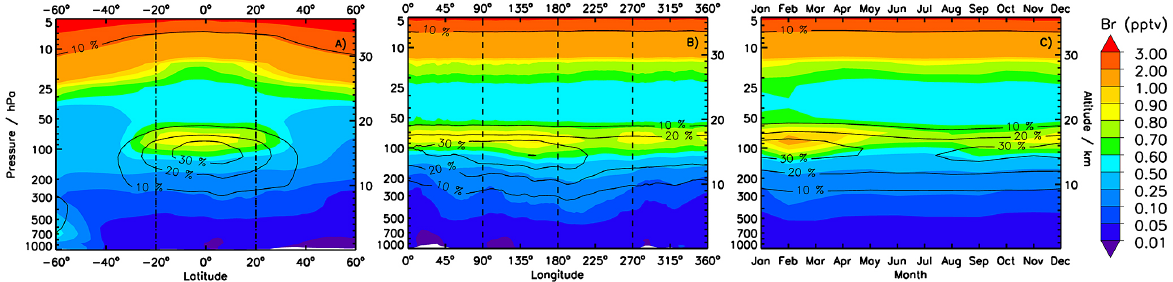
Figure 3. The “tropical ring of atomic bromine”: (a) annual zonal average; (b) annual meridional average abundance of atomic Br within the tropics (20 ◦ N–20 ◦ S); and (c) seasonal evolution of the zonally averaged atomic Br ring within the tropics. The color scale represents noontime volume mixing ratios (pptv) while black contour lines show the percentage contribution of atomic Br to Br y .